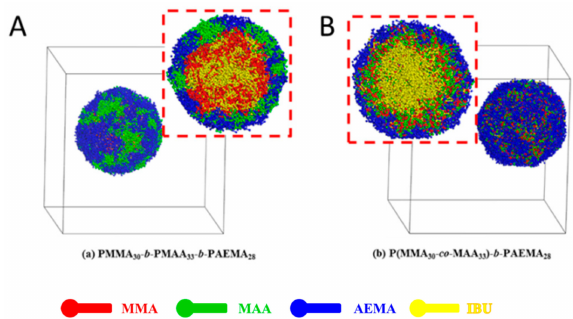
Figure 6. Full-section and cross-section views of IBU-loaded PMs self-assembled from precise line block copolymer ( A ) or random block copolymer ( B ) together with